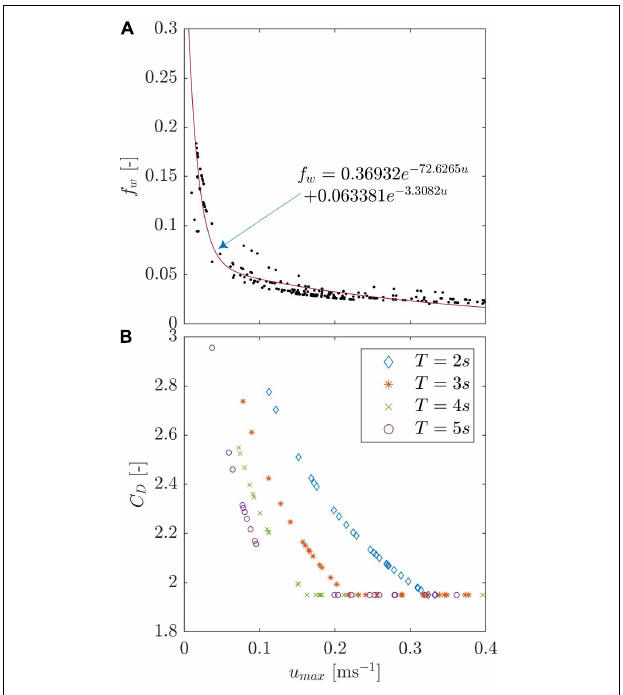
FIGURE 11 | (A) Exponential fit ( R 2 = 0.92 , RMSE = 0.0147 ) for the calculation of the friction factor f w for all sets of waves trialed (with and without artificial seagrass). Uncertainty given in Equation 12. (B) C D calculated from KC with C D = max ( 10 KC − 1 / 3 , 1 . 95 ) (Luhar and Nepf, 2016) as a function of the incident wave period T